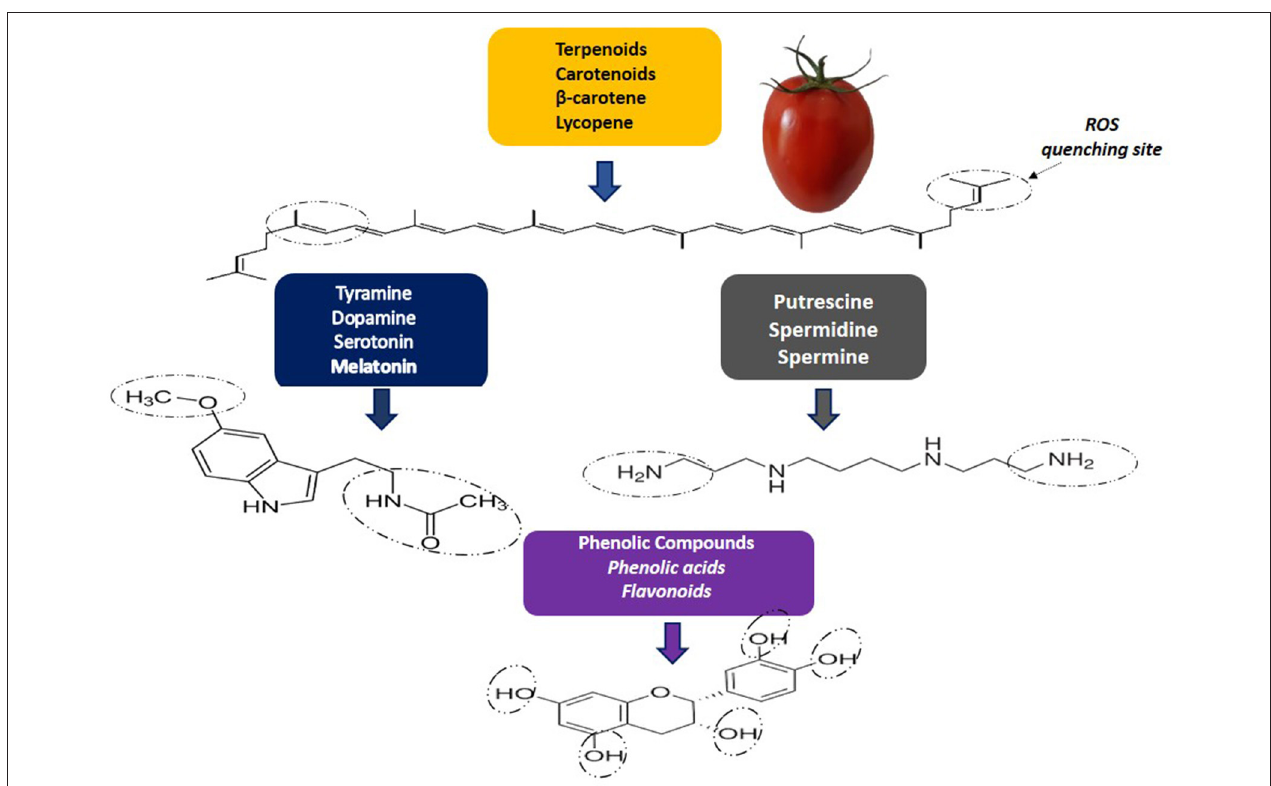
FIGURE 1 | Reactive oxygen species (ROS) by phytochemical